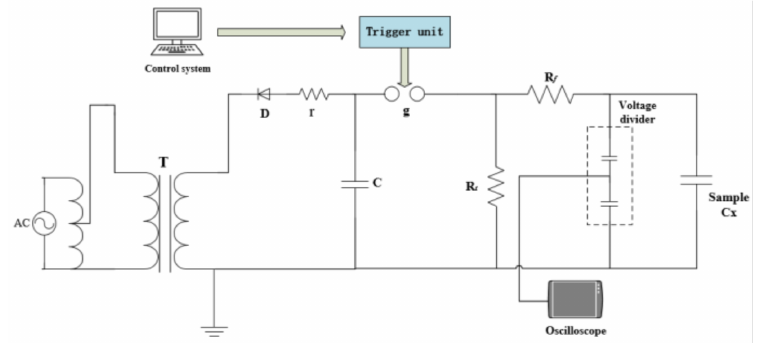
Figure 5. Experimental schematic diagram of impulse voltage generator.